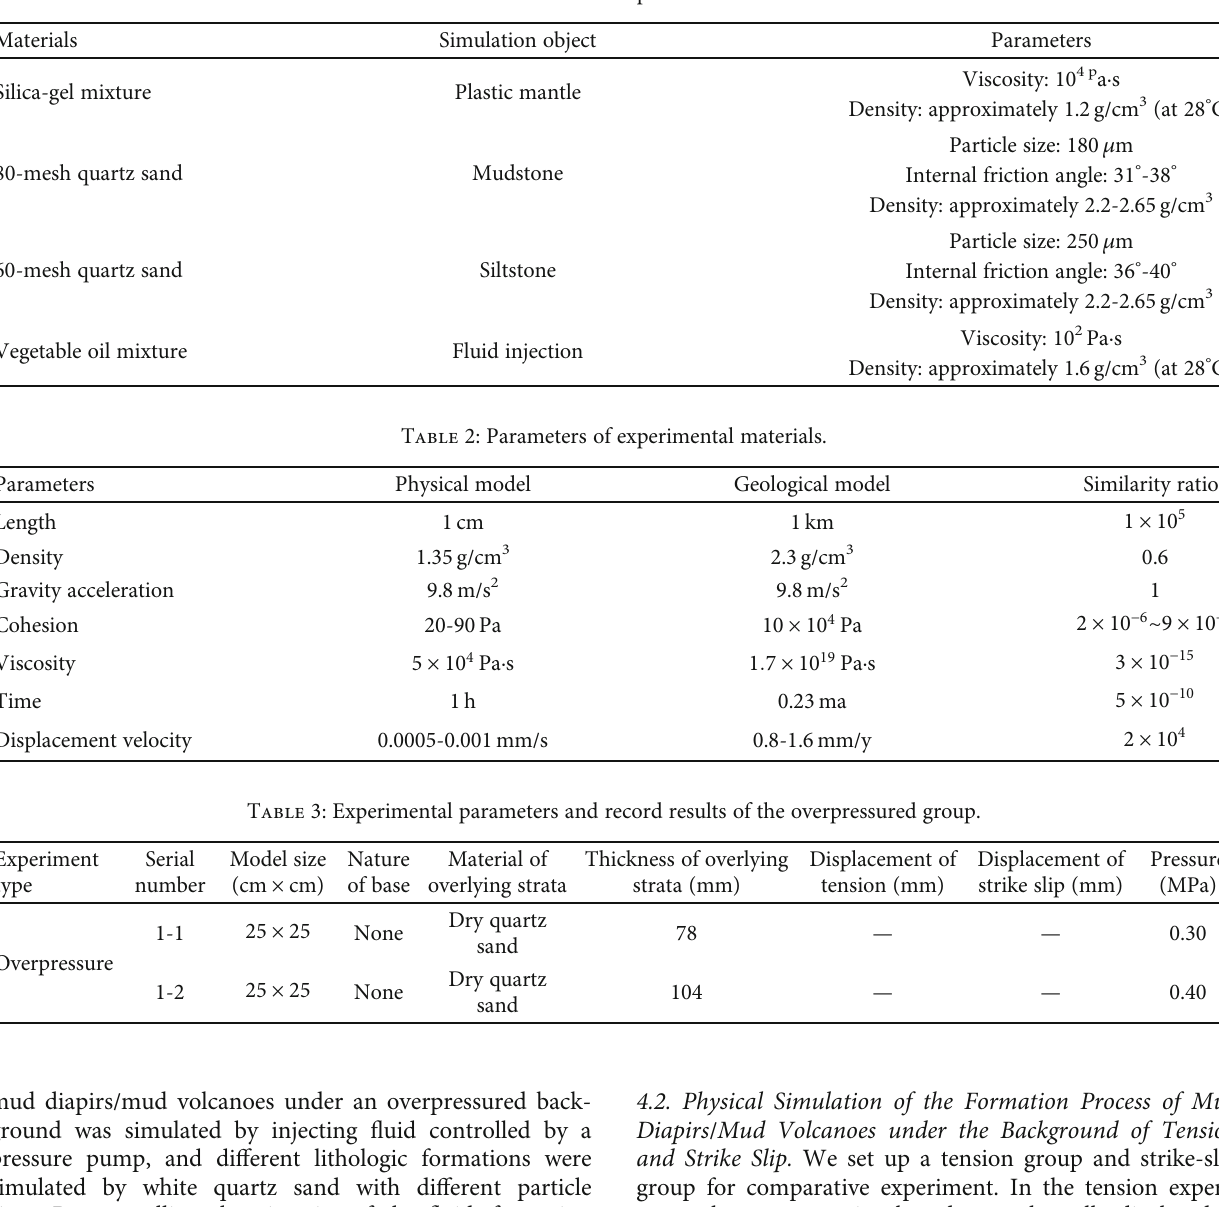
Table 1: Parameters of experimental materials.